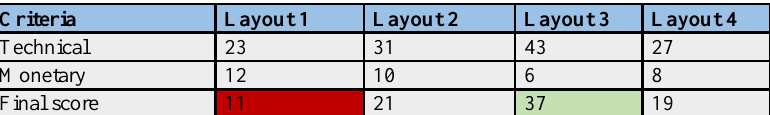
Table 3. Final score of the 4 layouts.